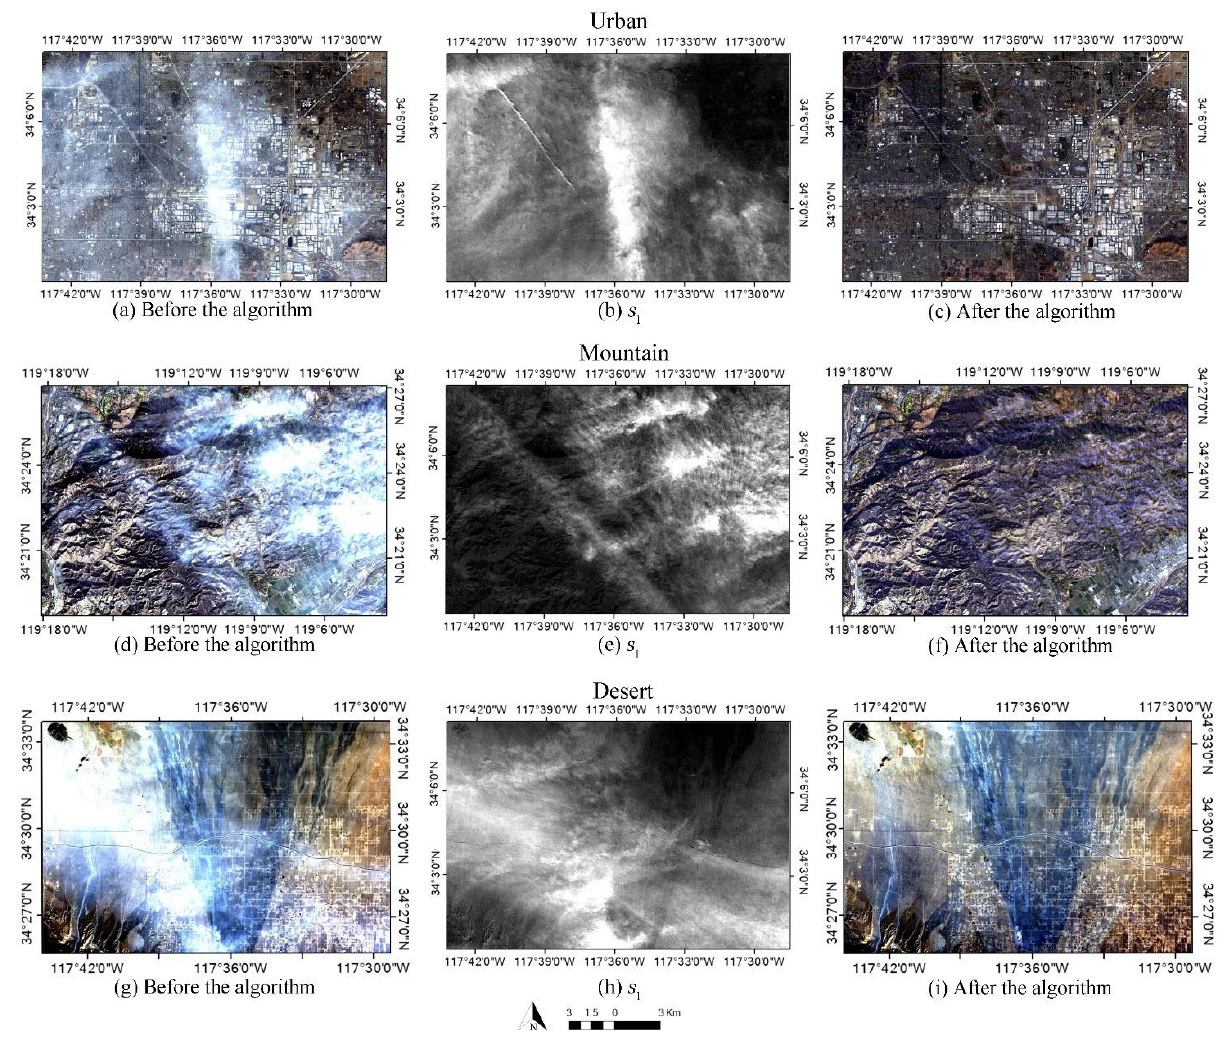
Figure 11. Three subimages extracted from the image of p41/r36 of Landsat-8 OLI data acquired on 8 January 2014. ( a ) The original urban image. ( b ) The cloud component of the image. ( c ) The image after the algorithm. ( d ) The original mountainous image. ( e ) The cloud component of the image. ( f ) The image after the algorithm. ( g ) The original desert image. ( h ) The cloud component of the image. ( i ) The image after the algorithm. ( a ), ( c ), ( d ), ( f ), ( g ), and ( i ) are the color composites with Band 4 as red, Band 3 as green, and Band 2 as blue, respectively. ( b ), ( e ), and ( h ) are in gray